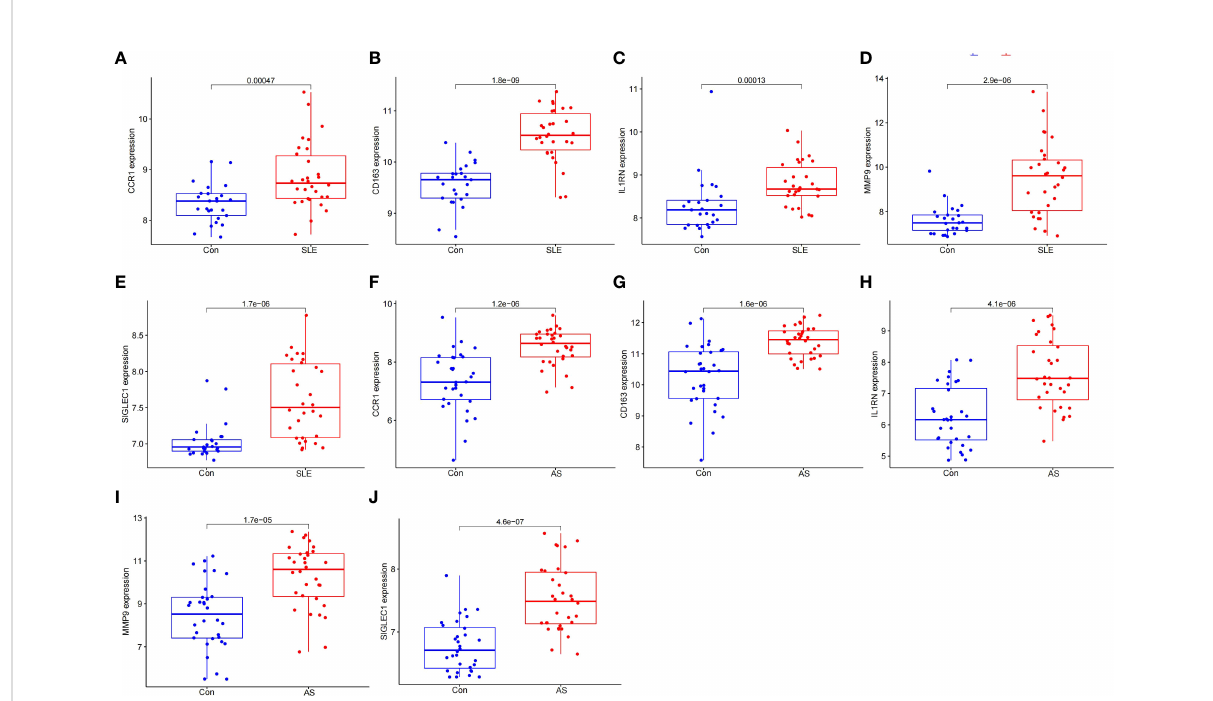
FIGURE 6 Validation of HGs expression. (A – E) Expression of the fi ve HGs veri fi ed in GSE81622. (F – J) Expression of the fi ve HGs veri fi ed in